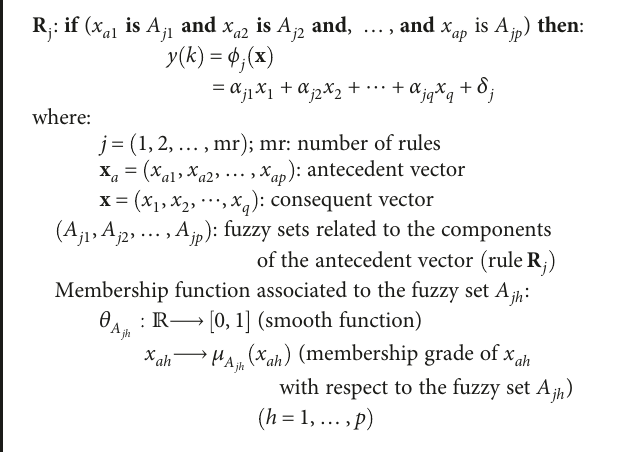
Figure 4: Identi fi cation data of case A (inputs).